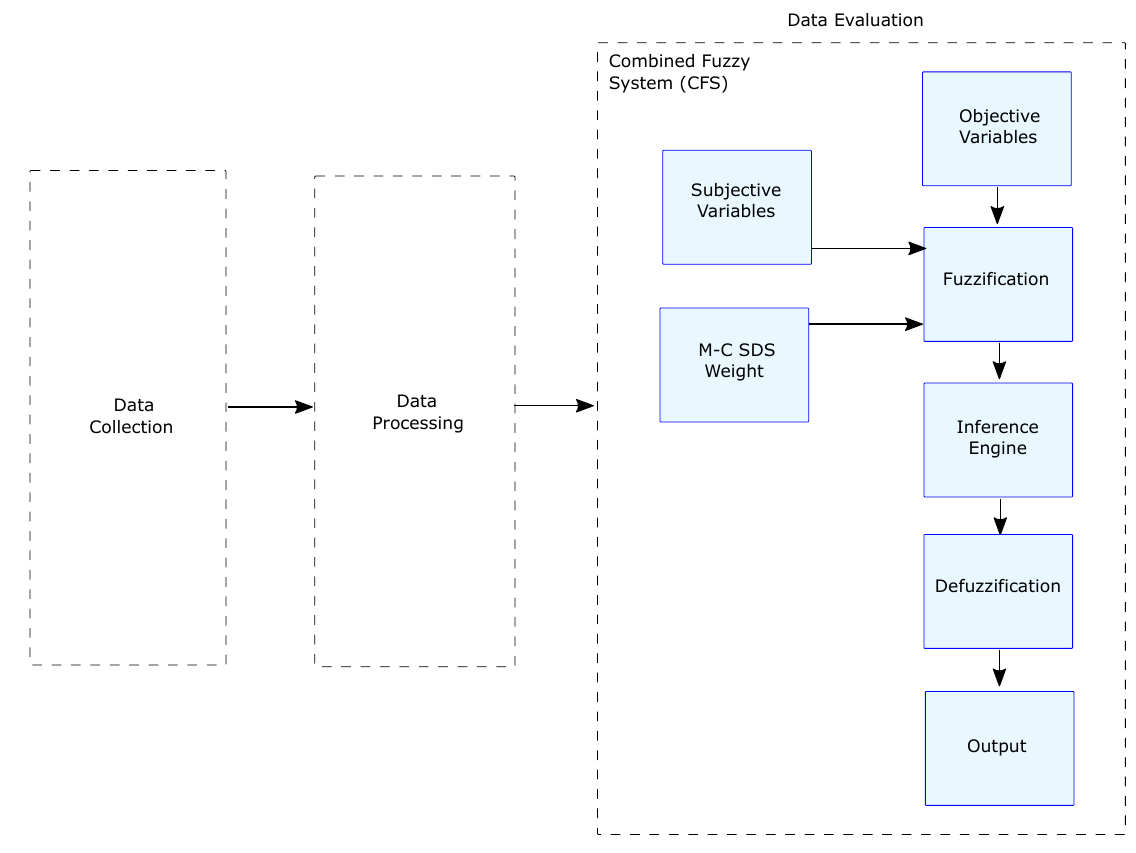
Figure 4. Data evaluation